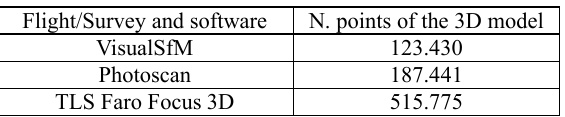
Table 5: Number of points North facade